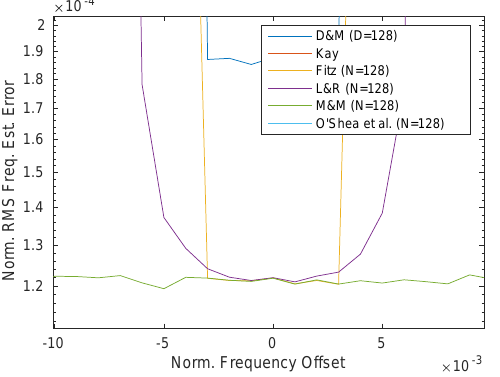
Figure 16. Frequency estimation range details ( D = 128; N = 128). Finally, one thing to note is that L&R shows a non-perfectly flat estimate within the estimation range, which can be up to 1.5 × the lower high-N value (i.e., N = 128) as visible in Figure 16. This effect has to be checked when the system is planned to be used also near its estimation edges. As a next step in the analysis to check the performances with different channel conditions, i.e., different values of E b / N 0 , another set of simulations has been performed using a carrier frequency offset ∆ f = 0, while sweeping the noise level E b / N 0 from − 5 dB to 23 dB to simulate the different noise condition in the CCSDS 131.2-B-1 design range. The output of this simulation is shown in Figure 17.